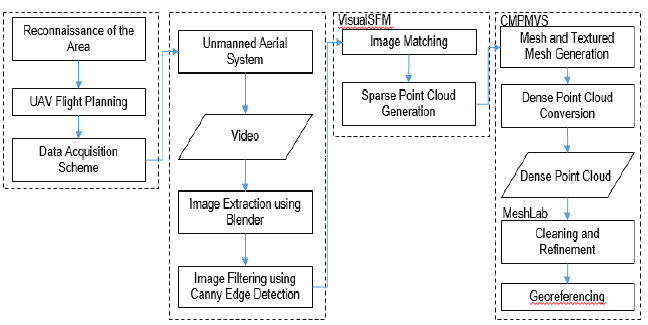
Figure 2. As-built 3D model generation